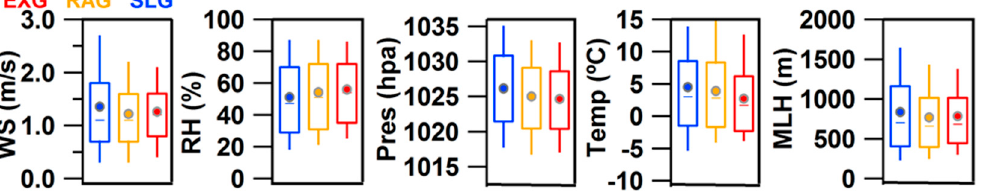
Figure 9. Statistic graphs of temperature (Temp), pressure (Pres), wind speed (WS), humidity (RH), and mixed layer height (MLH) before the explosive, fast, and slow growth in Beijing.